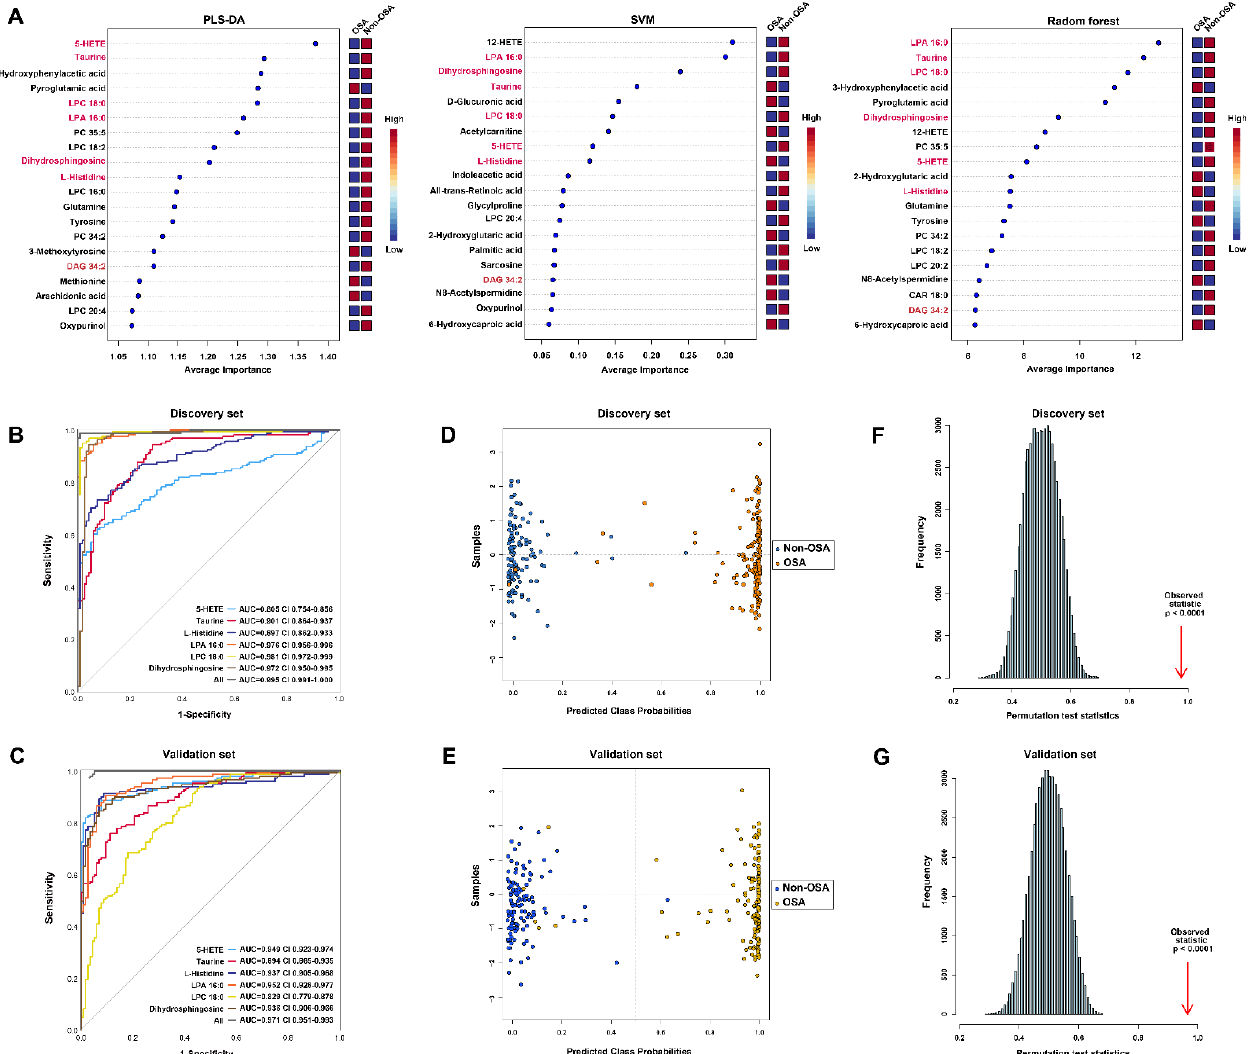
Figure 6. Multi-metabolite model for diagnosing OSA in hypertension by using multiple machine learning algorithms and receiver operating curve. ( A ) The top 20 metabolites were ranked on the basis of their average importance contributing to the diagnosis of OSA in hypertension (classification accuracy). The overlapping six metabolites obtained from three machine learning algorithms were marked in red. ( B , C ) Logistic regression-based receiver-operating characteristic curve analyses of the diagnostic performances for individual metabolite and their combinations in discovery and validation set. ( D , E ) Plot of posterior classification probability showing the segregation of hypertension comor- bid OSA and non-OSA hypertension samples according to the predictive six-metabolite model. Each symbol represents the classification probability that a given sample belongs to OSA or to non-OSA group. The classification boundary is shown by a dotted line at x = 0.5. ( F , G ) The permutation test ( n = 1000 times) showing the robustness of predictive model generated by six-metabolites. The univariate-receiver-operating curve (ROC) of each metabolite yielded an area under ROC (AUC) >0.8 for discriminating OSA from non-OSA subjects in both